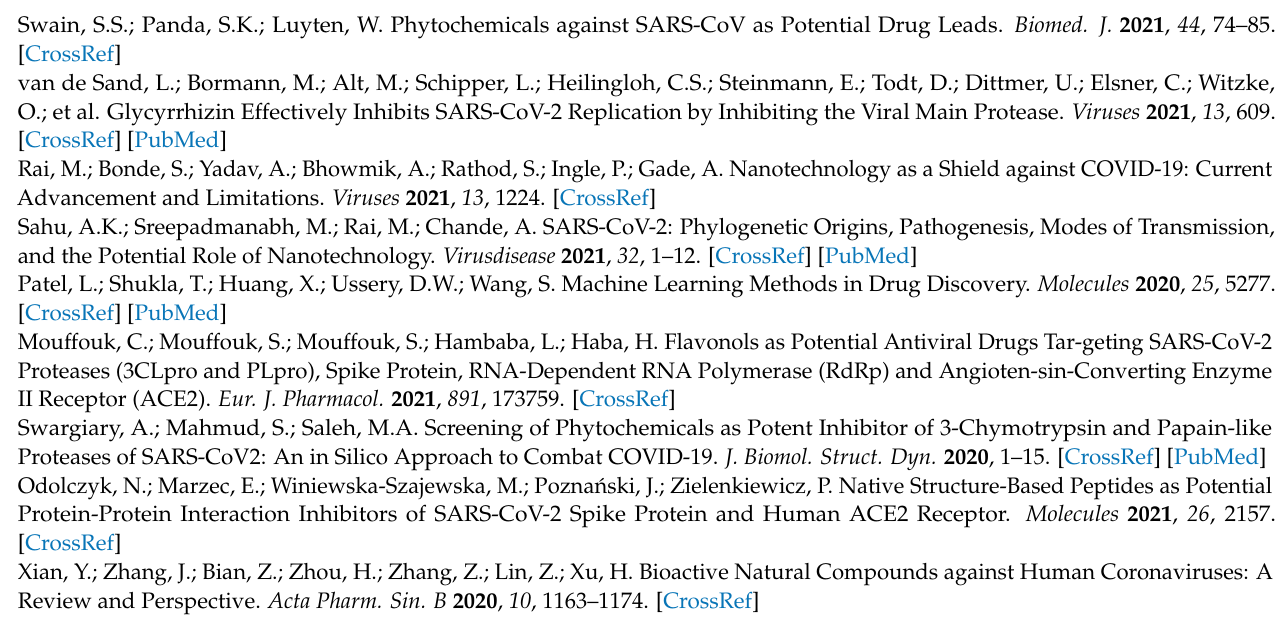
Table S2: Complete dataset with a full list with descriptors; Figure S1: Molecular representations for the used